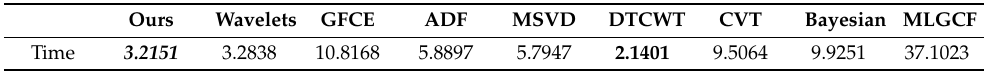
Table 3. Running times of scenes with different methods.